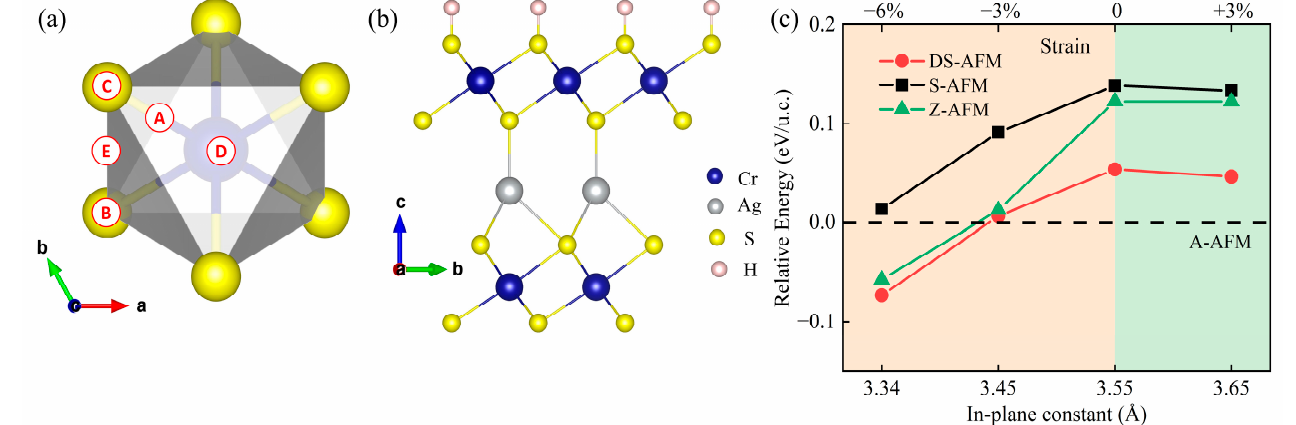
Figure 4. ( a ) Possible adsorption sites for hydrogen. B, C, D denote the adsorption sites above the lower and upper S ions and Cr ion in the adjacent CrS 2 layer, respectively. While, A and E are the adsorption sites located between CD and BC, respectively. ( b ) Side view of the ground structure of unilaterally passivated AgCr 2 S 4 H. ( c ) AgCr 2 S 4 H ground state phase diagram as a function of the lattice constant. Relative energy per unit cell is shown on the left axis. The energy of optimized free-standing structure with A-AFM ground state is taken for reference. Upper axis: the equivalent biaxial strain, defined as ( a − a 0 )/ a 0 , where a 0 and a are the in-plane lattice constants before and after stress application,